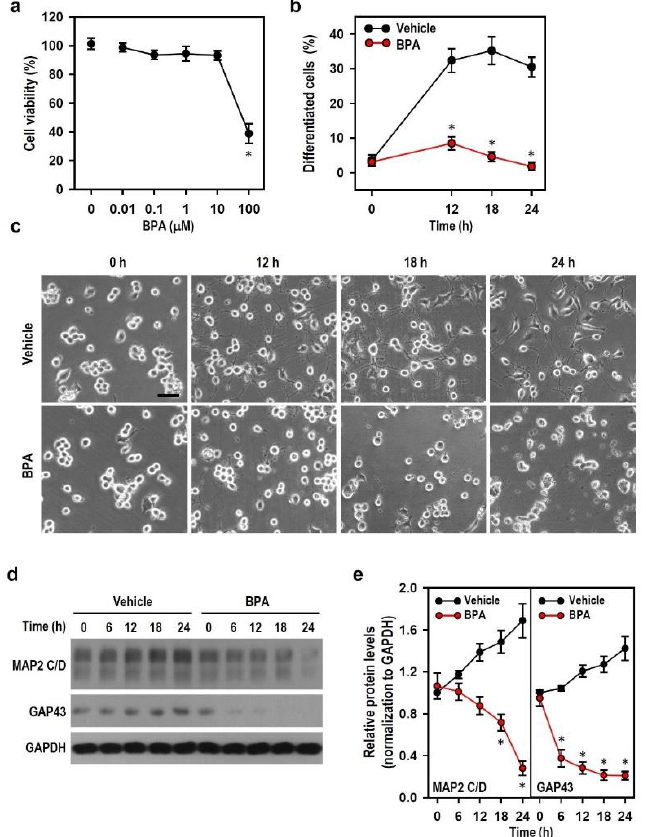
Figure 1. Bisphenol A (BPA) reduces cell viability and neuron-like differentiation in Neuro-2a (N2a) cells. ( a , b ) Cultures were treated with various BPA concentrations (0 to 100 µ M) for 24 h and incubated with 100 µ M BPA or vehicle for different time lengths (0 to 24 h). The untreated culture (0 µ M BPA) was regarded as the control group. The cell viability and differentiation levels were separately determined by analyzing the MTT reduction capacity of the treated group rela- tive to the control group (assigned a value of 100%) and by calculating the number of cells (% of total) bearing axon-like neurites longer than two cell-body in diameter. Each point represents the mean ± SEM ( n = 4, triplicate). * p < 0.05 vs. control group ( a ) or vehicle group at identical